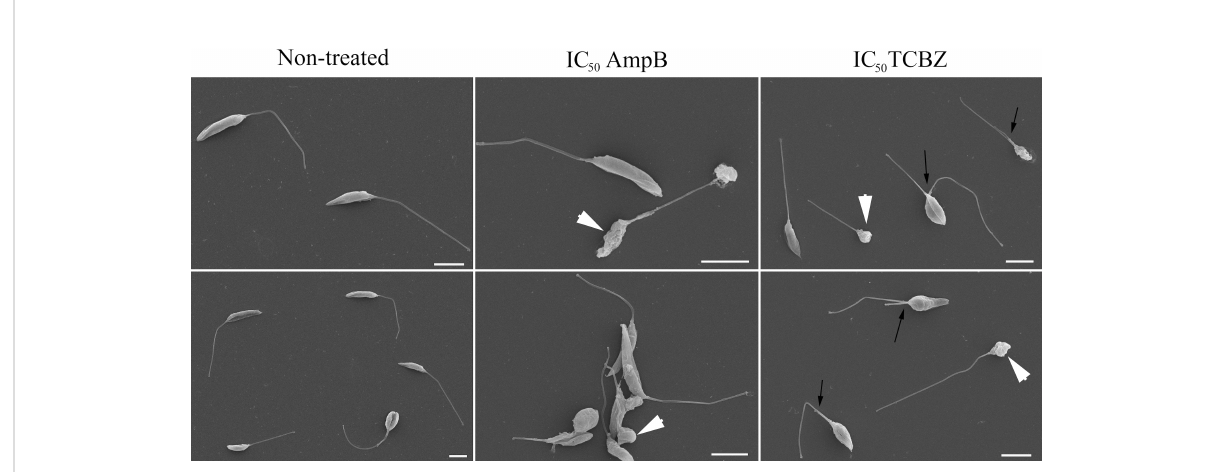
FIGURE 7 Morphological analysis of L. amazonensis promastigotes by scanning electron microscopy (SEM). The fi rst column represents non-treated parasites, and the second and third columns represent parasites treated with AmpB IC 50 /72h and TCBZ IC 50 /72h, respectively. White arrowheads show shrinkage and roundness in the parasites that are presented in both AmpB and TCBZ treatment. Black arrows point to parasites in division, which was observed in a higher frequency in TCBZ treatment, when compared to control or AmpB treatment. Bars: 5 µm.